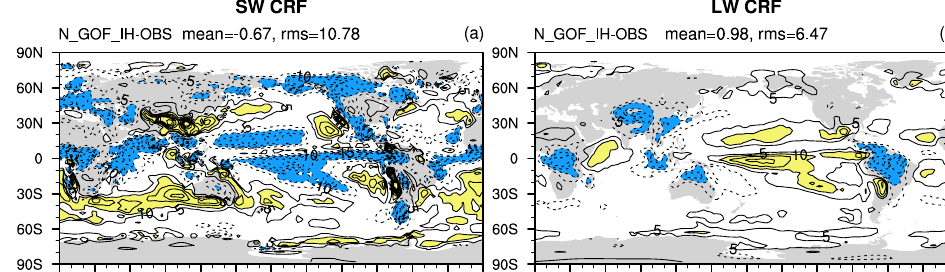
Fig. 12. The same as Fig. 3 (c, d) , but for the simulation N_GOF_IH.